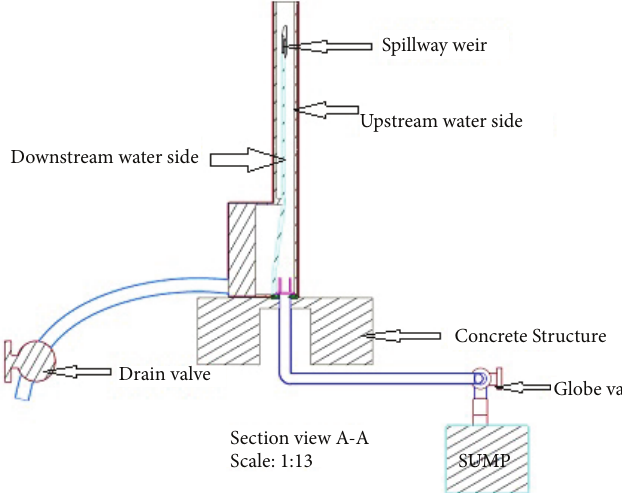
Figure 1: Schematic of experimental setup.